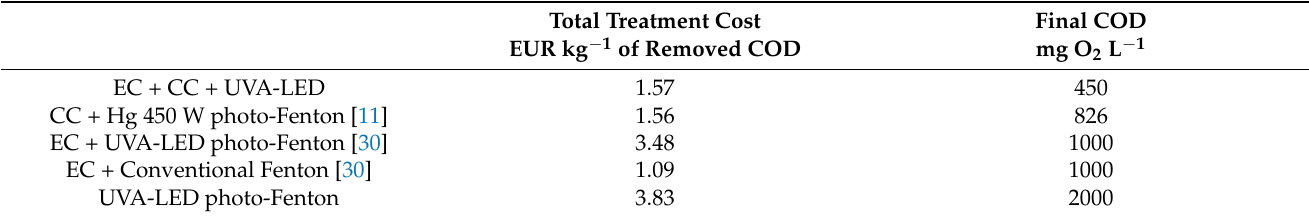
Table 5. Comparison of treatment cost (excluding sludge management) and final COD result among different pre- treatment alternatives for the photo-Fenton treatment ([H 2 O 2 ]:COD = 1.063) of similar mature landfill leachate samples (COD ≈ 5000 mg L − 1